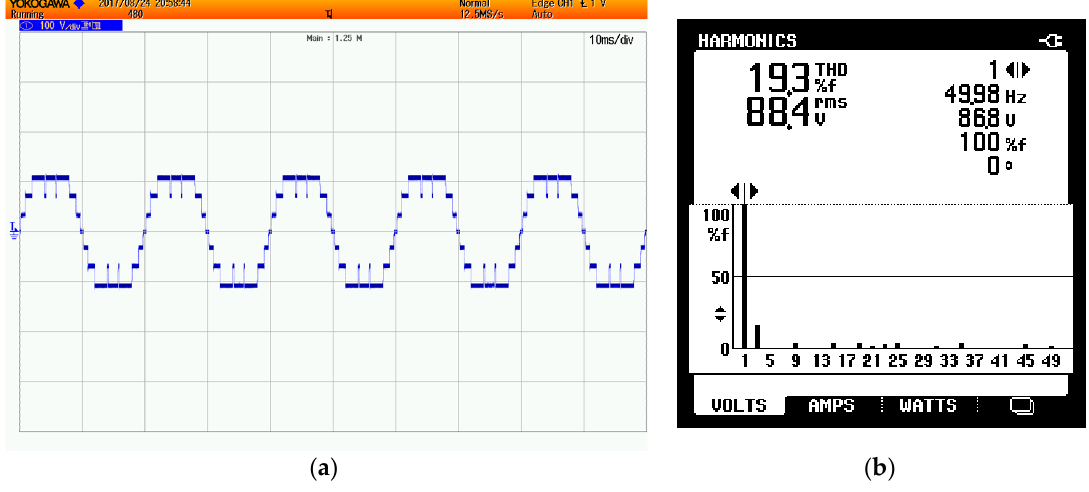
Figure 13. Experimental results of output voltage and THD of pattern of Figure 3c in ( a , b ) respectively.